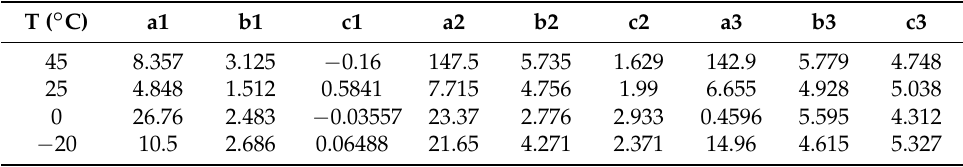
Table 5. The coefficient value of OCV-SOC sum of sin functions model (n = 3) fitting under different temperatures.